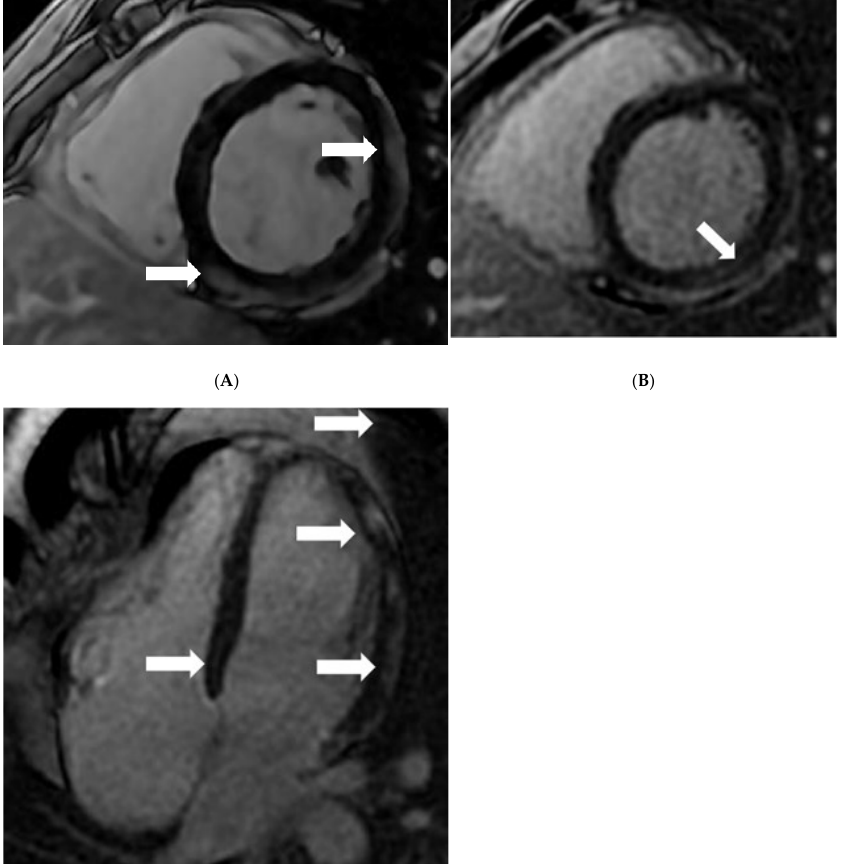
Figure 2. CMR imaging demonstrating T2w STIR 4 ch view with multiple increased signal intensity in anterolateral and lateral segments (arrow).